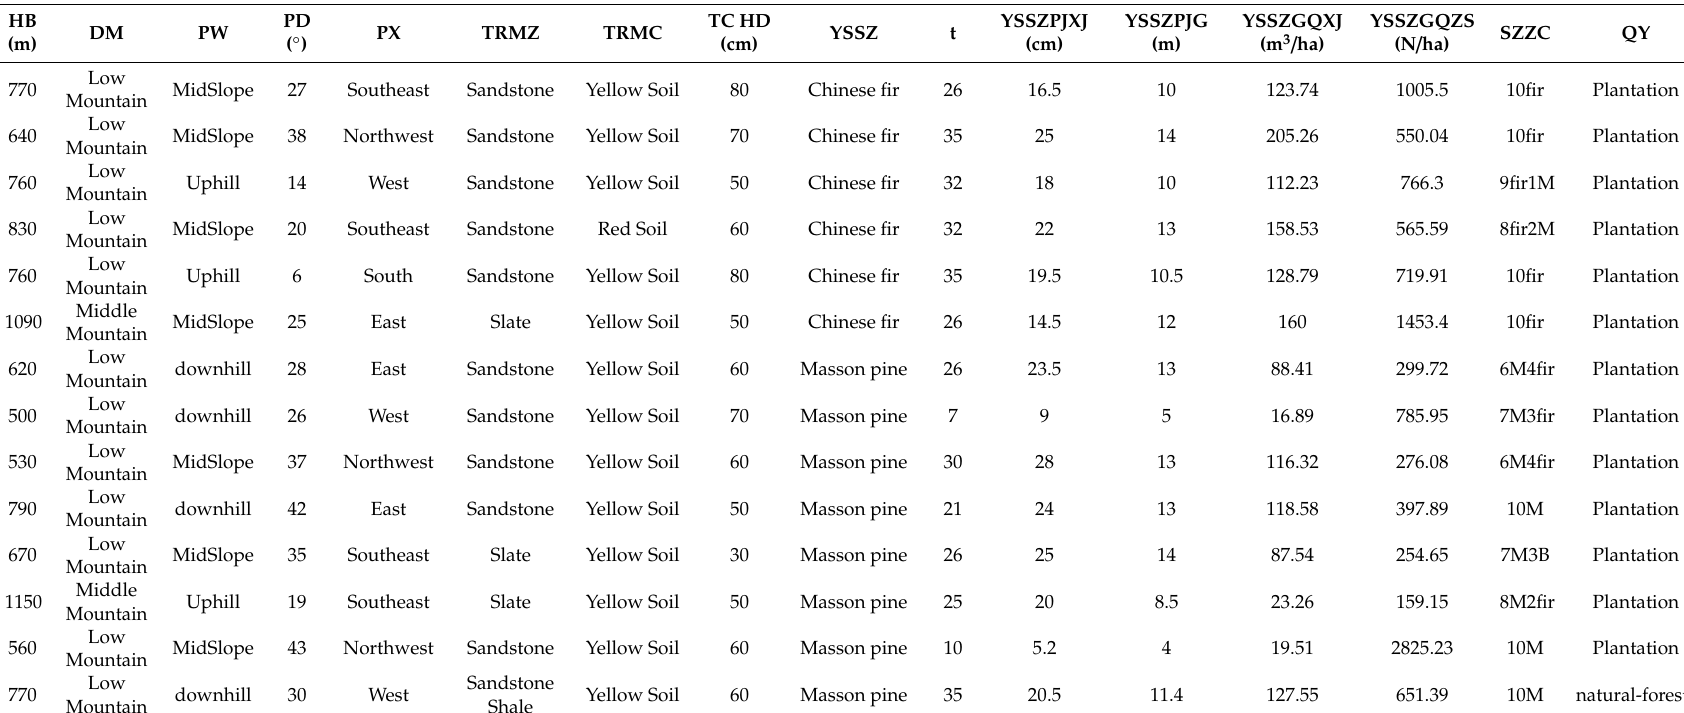
Table 1. Growth information of the forest resource subcompartment data in Jinping County of Guizhou Province in